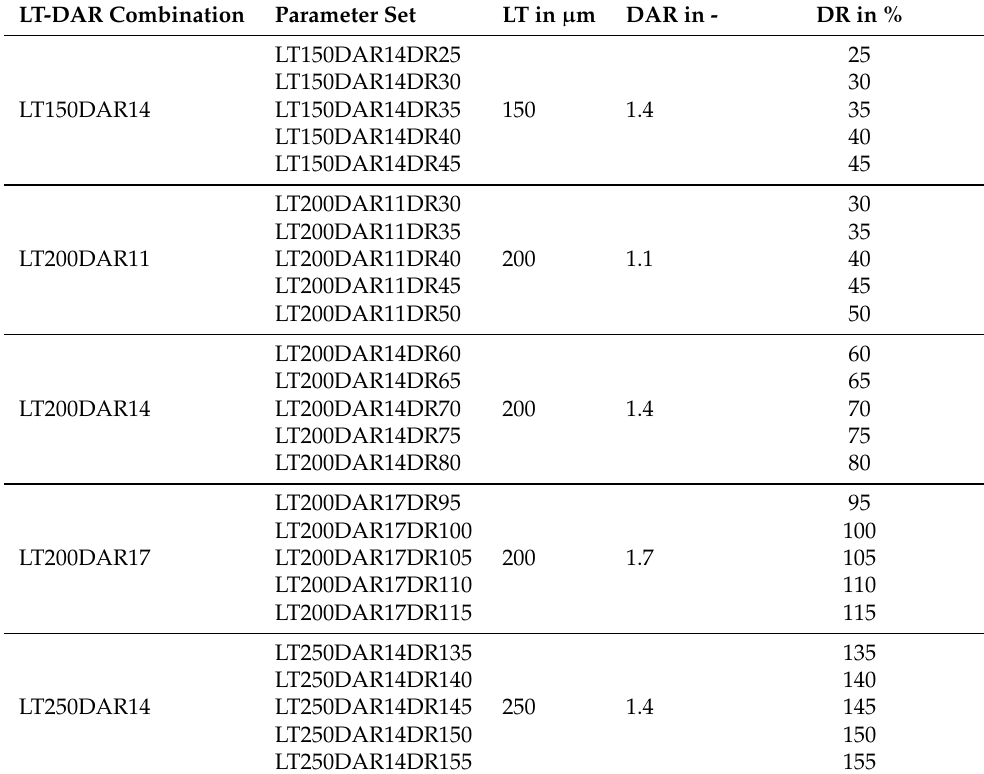
Table 1. Overview of the five LT-DAR combinations and the parameter sets resulting with the selected DR. Specimens were manufactured for measurement of density and surface analysis.